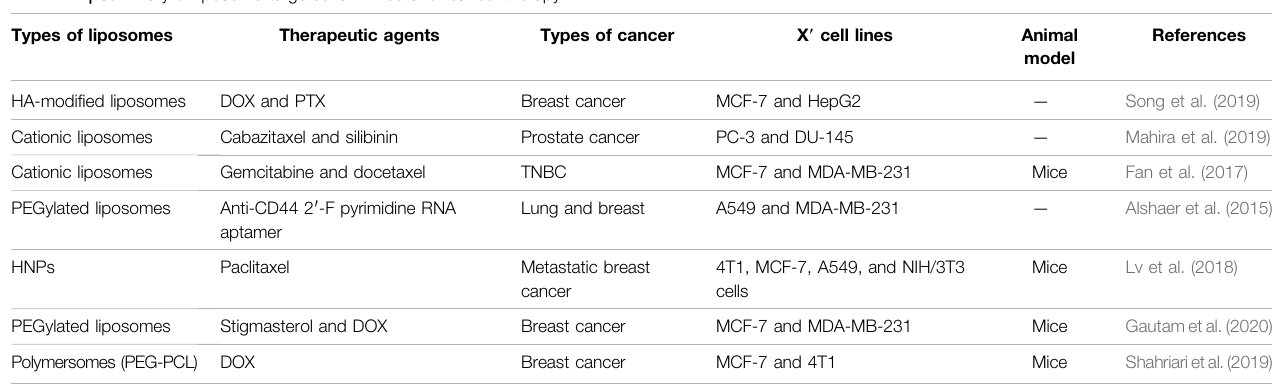
TABLE 1 | Summary of liposome-targeted CD44 cells for cancer